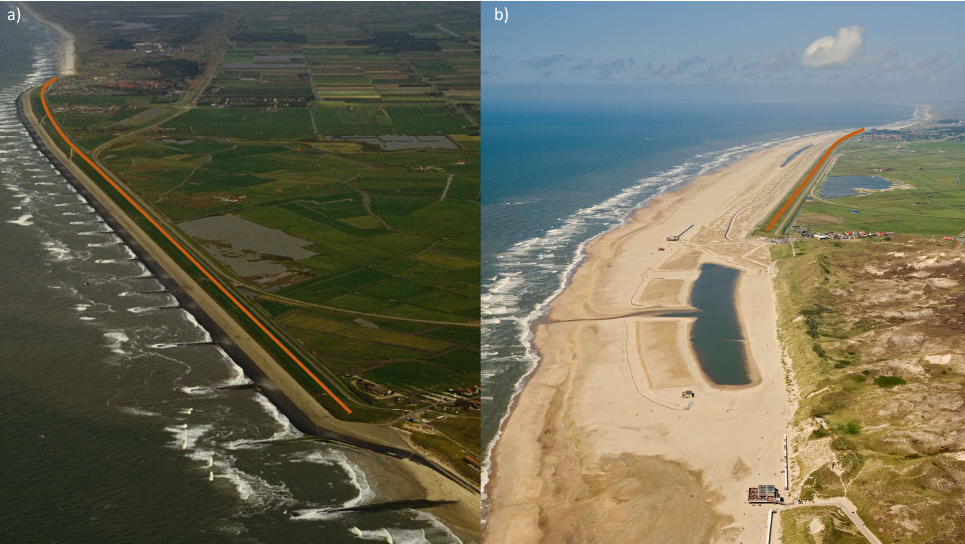
Figure 1. ( a ) Hondsbossche sea dike before placement of the nourishment (courtesy of Rijkswaterstaat, https://beeldbank.rws.nl/, accessed on 6 September 2021) and ( b ) the Hondsbossche Dunes Nour- ishment just after placement in April 2015 (courtesy of Aannemerscombinatie Zwakke Schakel–Van Oord-Boskalis). The orange line marks the crest of the original sea